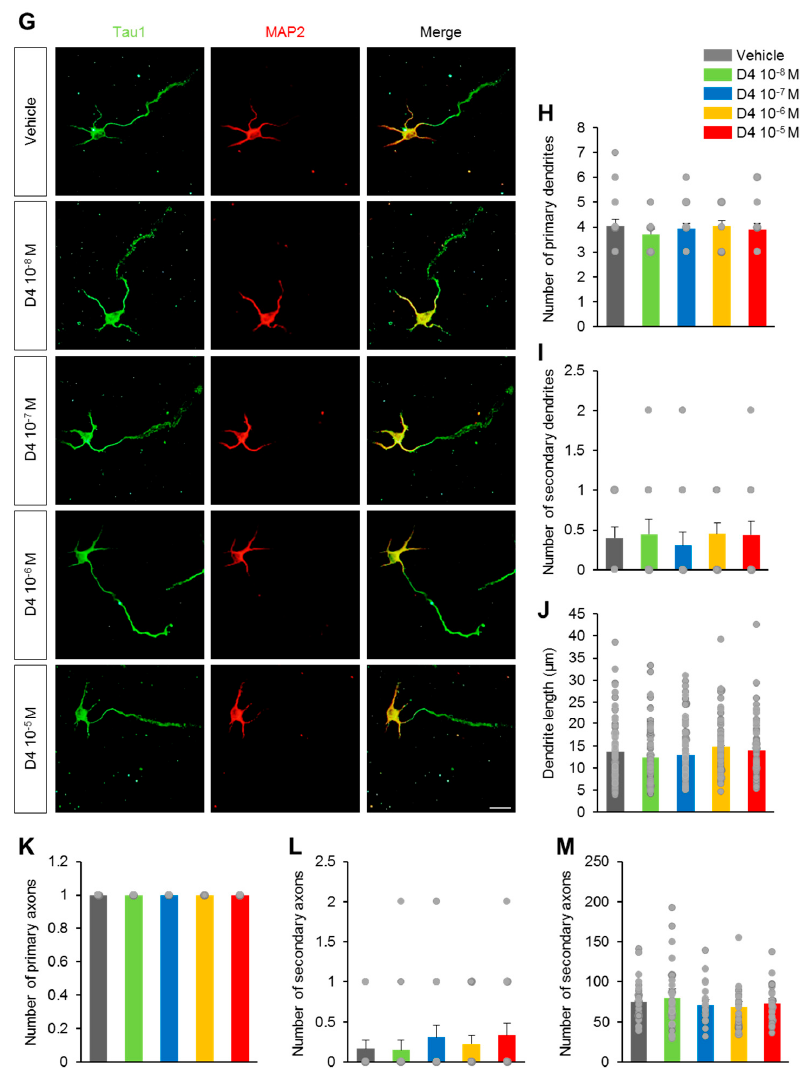
Figure 1. Cytotoxic effect of D4 on Sox1 − GFP mouse embryonic stem cells and primary cortical neuron cells. ( A ) CCK8 assays were used to detect the difference in the viability of Sox1 − GFP mouse embryonic stem cells after 48 h of treatment with different doses of D4. ( B ) The resultant intensity of integral GFP was observed after 96 h of treatment with different doses of D4. The IC50 and ID50 effects of D4 increased in strength with increasing dose. ( C ) Primary cortical neuronal cells were treated with D4 at DIV 1 and incubated with 10 μ M BrdU for 2 h, 12 h after adding D4. Cells were fixed and immu- nofluorescence with BrdU antibodies (red). Scale bar: 40 μ m. ( E ) Quantification of ( C ). The percentage of BrdU + cells were decreased in the D4 10 − 6 M and D4 10 − 5 M groups compared to vehicle, D4 10 − 8 M and D4 10 − 7 M groups (F 4,100 = 37.50, p < 0.0001). ( D ) Cell death was assessed by staining with a cleaved caspase-3 antibody (green) 12 h after administration of D4. Scale bar: 100 μ m. ( F ) Quantification of ( D ). D4 − treated groups, except D4 10 − 8 M group, showed higher in the percentage of cleaved caspase-3 + cells compared to vehicle group, (F 4,128 = 7.614, p < 0.0001). n = 5 cell culture replicates using 5 mice for each condition (cell counts: 1000 cells for each group). ( G ) Representative images of cultured mouse primary cortical neuron at DIV 4 stained with antibodies against MAP2 (red) and Tau1 (green). Scale bar: 100 μ m. ( H − M ) Quantification of relative number and length of dendrite and axon. ( H ) The number of primary dendrites, ( I ) number of secondary den- drites, ( J ) average dendrite length, ( K ) number of primary axons, ( L ) number of secondary axons, ( M ) average axon length. D4 − treated groups showed no significant difference in the number and the length of dendrite and axon. Data represent mean ± SEM. Statistical significance was determined by one − way ANOVA with Bonferroni correction. * p < 0.05 vs. vehicle, *** p < 0.001 vs. vehicle, ## p < 0.01 vs. 10 − 7 mol/L, ++ p < 0.01 vs. 10 − 5 mol/L, +++ p < 0.001 vs. 10 − 5 mol/L. Treatments: vehicle; 0.1% DMSO, D4; 10 − 8 mol/L, 10 − 7 mol/l, 10 − 6 mol/L, or 10 − 5 mol/L.